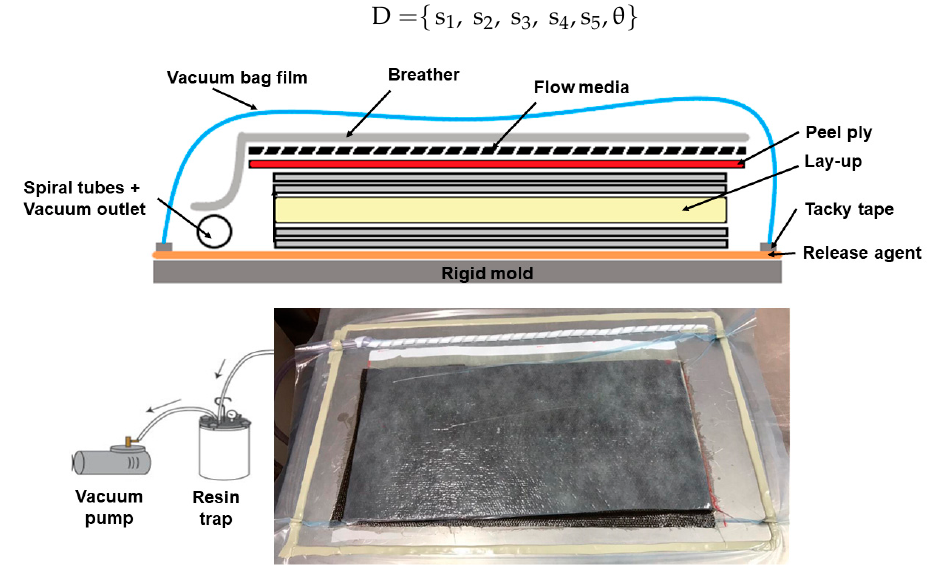
Figure 3. Vacuum bag processing, for the SP